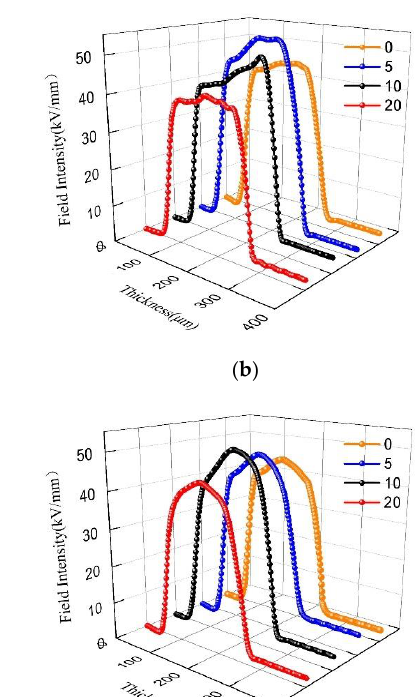
Figure 8. Average charge density for each sample at 40 kV/mm field intensity. ( a ) Sample 1; ( b ) Sample 2; ( c ) Sample 3; ( d ) Sample 4.